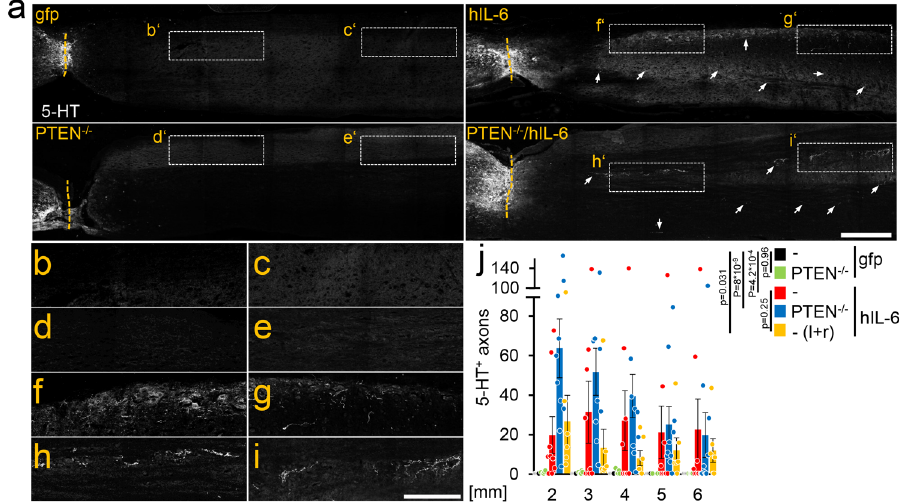
Fig. 4 hIL-6 promotes axon regeneration of serotonergic fi bers. a Sagittal thoracic spinal cord sections isolated from PTEN + / + , or PTEN − / − animals 8 weeks after spinal cord crush (SCC) and unilateral injection of AAV2-hIL-6 (hIL-6) or AAV2-GFP (gfp) (see Fig. 2). Raphe spinal tract (RpST) axons were stained using an anti-serotonin antibody (5-HT, white). Only AAV2-hIL-6-treated mice with or without additional PTEN − / − showed signi fi cant regeneration of serotonergic axons beyond the lesion site (dashed line). As typical for regenerating RpST axons they were located over the whole dorsoventral width of the spinal cord. Examples are indicated by dashed boxes and white arrows. Scale bar: 500 µ m. b – i Higher magni fi cation of dashed boxes as indicated in ( a ). Scale bar: 250 µ m. j Quanti fi cation of regenerating 5-HT-positive axons as described in ( a ) at indicated distances beyond the lesion. Values represent the mean ± SEM of 6 – 10 animals per group (PTEN + / + /gfp, n = 7; PTEN + / + /hIL-6, n = 9; PTEN − / − /gfp, n = 6; PTEN − / − /hIL-6, n = 10; PTEN + / + /hIL-6 (l + r); n = 6). Signi fi cances of intergroup differences were evaluated using a two-way analysis of variance (ANOVA) with a Holm Sidak post hoc test. Dots in j represent values of single animals. P -values indicate statistical signi fi cance; ns = non-signi fi cant. Source data are provided as a Source data fi